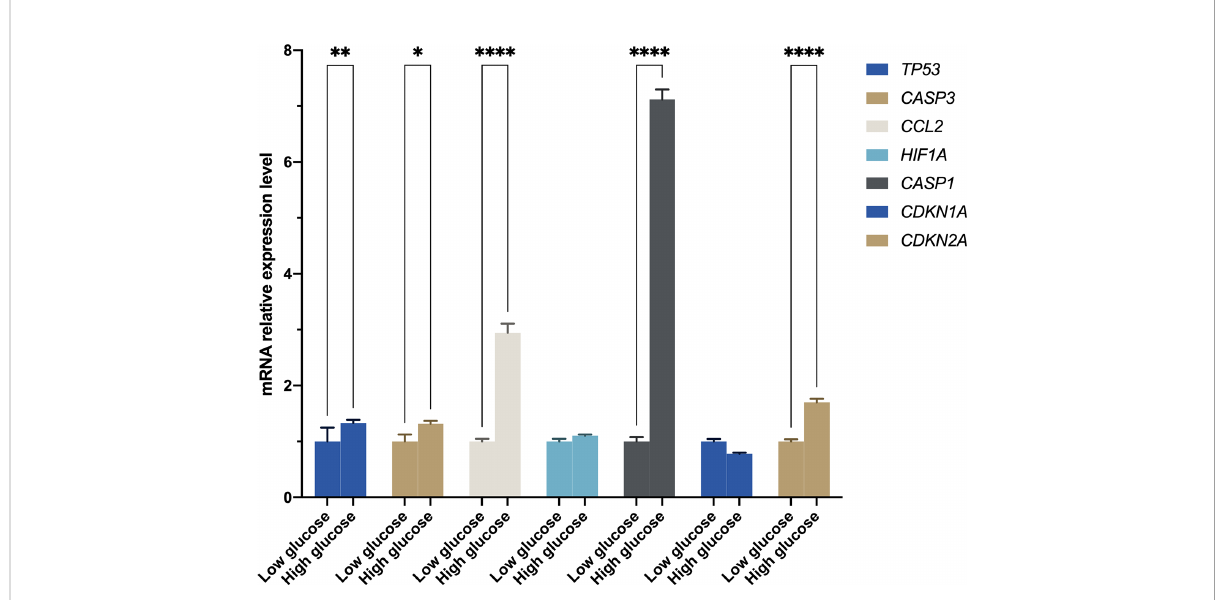
FIGURE 7 The mRNA level was evaluated in R28 cells by quantitative real-time polymerase chain reaction. P -values were calculated using Two-way ANOVA. * P < 0.05; ** P < 0.01; **** P <